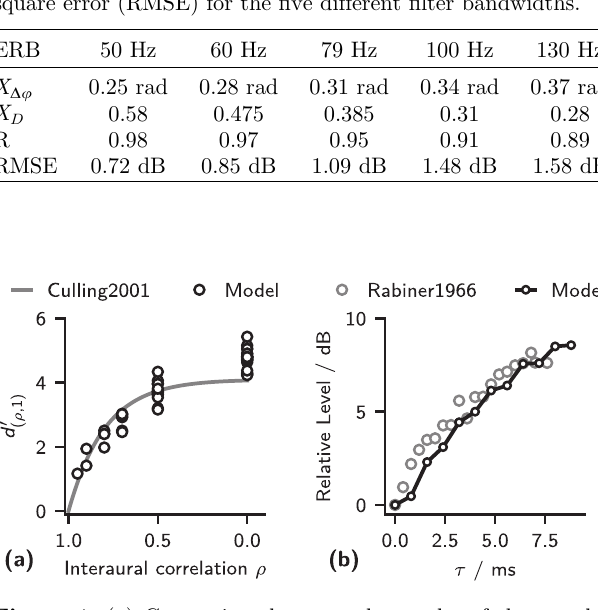
Figure 4. (a) Comparison between the results of the correla- tion-discrimination task of Culling et al. [39] (grey line shows their fi t for the average subject) and the model performance in the same task (b). Comparison between the model results (79-Hz fi lter bandwidth) and the data from Rabiner et al. [6], where the x -axis shows the group delay and the y -axis the associated threshold level relative to the s = 0